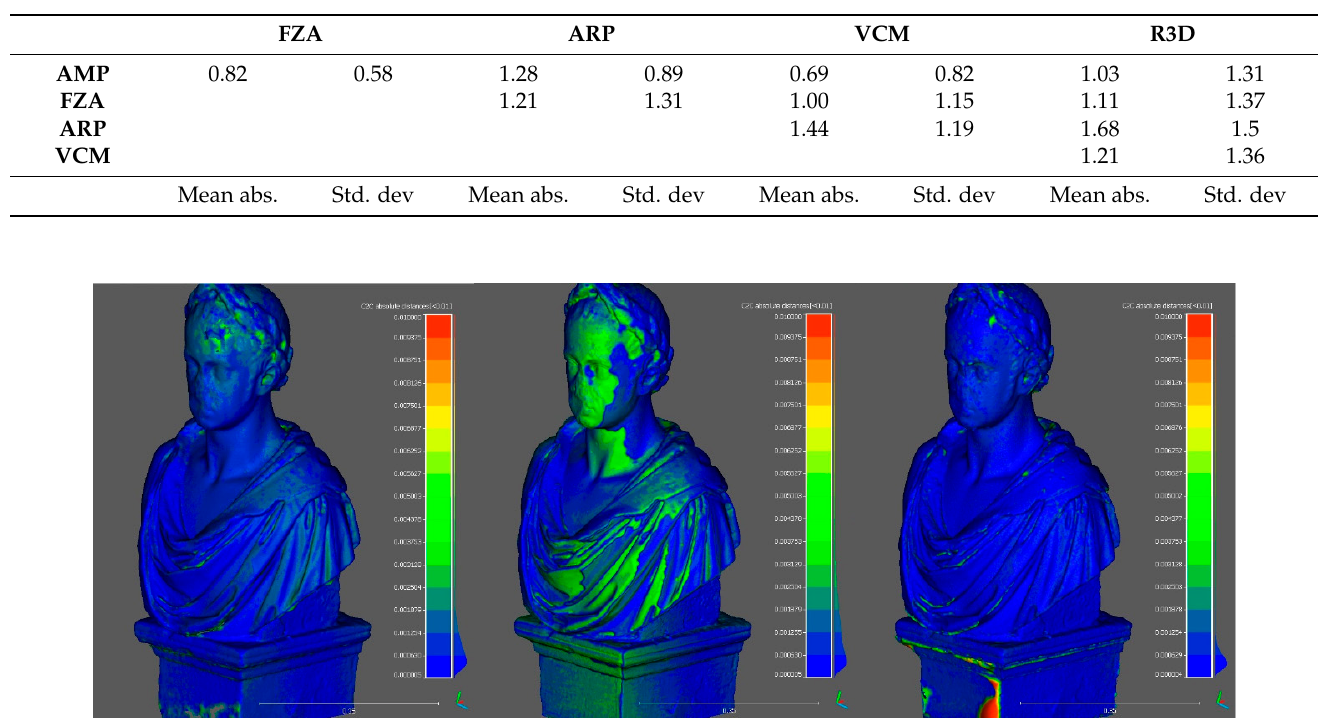
Figure 13. Scalar field mapping of Hausdorff distances for dataset 6 photogrammetric results. Deviation between the AMP mesh and the FZA mesh ( left ), deviation between the AMP mesh and the ARP mesh ( center ), deviation between the AMP and the VCM mesh ( right ); maximum visualized distance: 1 cm. Table 13. Hausdorff distances between the photogrammetric models for the stone bust case study—dataset 6 (distances in mm).